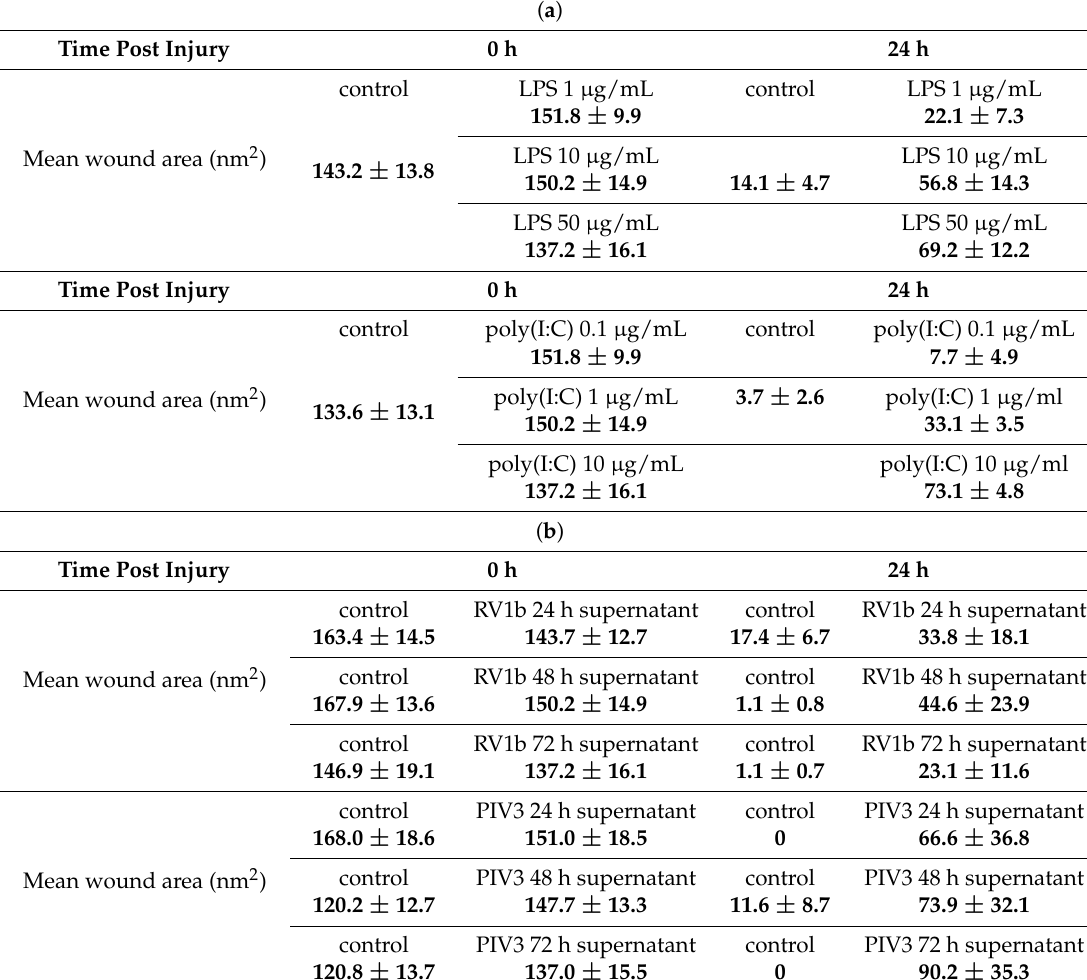
Table 1. ( a ) Mean wound area in cultures stimulated with the TLR agonists LPS and poly(I:C); ( b ) Mean wound area in cultures stimulated with supernatant from infected epithelial